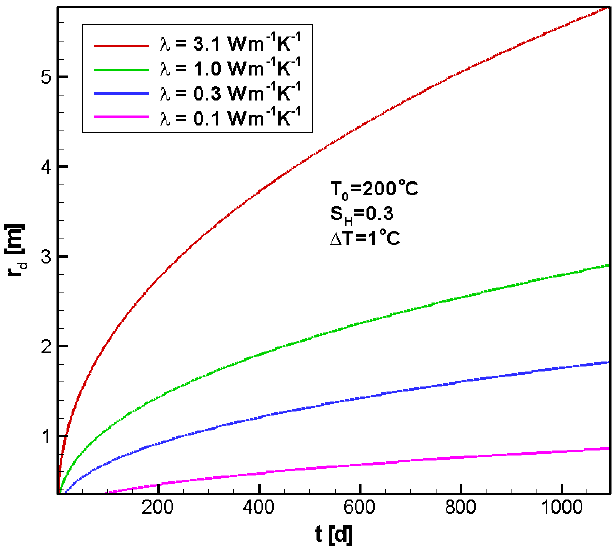
Figure 10. Evolution of hydrate dissociation radius and its sensitivity to the effective thermal